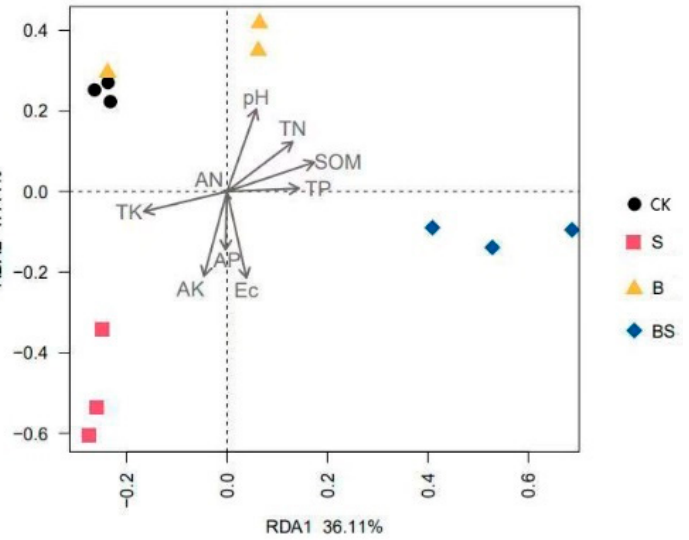
Figure 5. Redundancy analysis of soil bacterial community structures across four treatments. CK: organic substitution; B: organic substitution + biochar; S: CK + NaCl; BS: B +